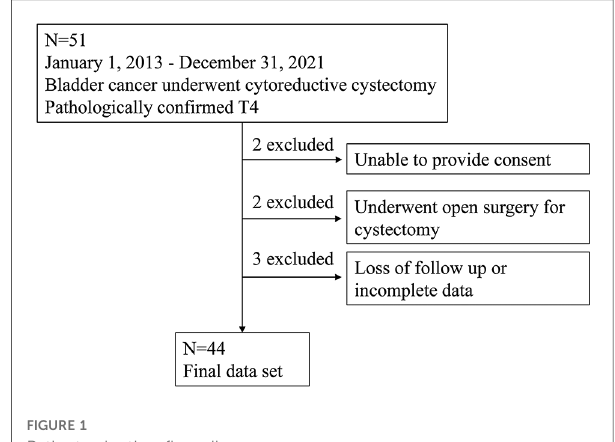
FIGURE 1 Patient selection fl ow